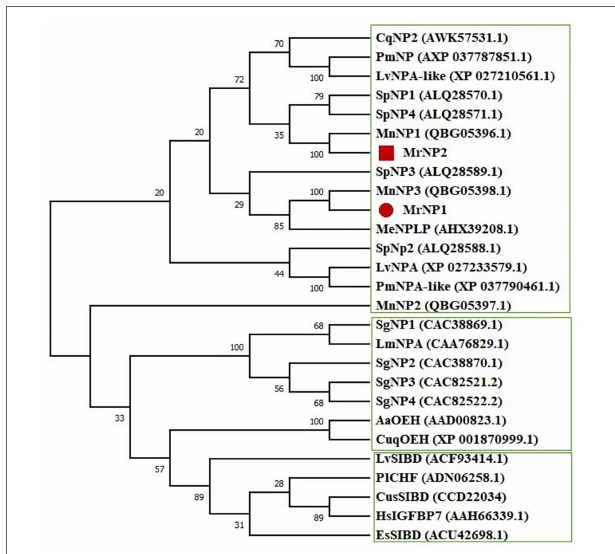
FIGURE 3 | Phylogenetic tree analysis of the M. rosenbergii neuroparsins (MrNP1, MrNP2) with other cysteine-rich related peptides from the crustaceans, insects, and other species. The sequences include Penaeus monodon NPA-like (GenBank# XP037790461.1); Litopenaeus vannamei NPA (GenBank# XP027233579.1); the locust Schistocerca gregaria NP1 (GenBank# CAC38869.1); S. gregaria NP2 (GenBank# CAC38870.1);